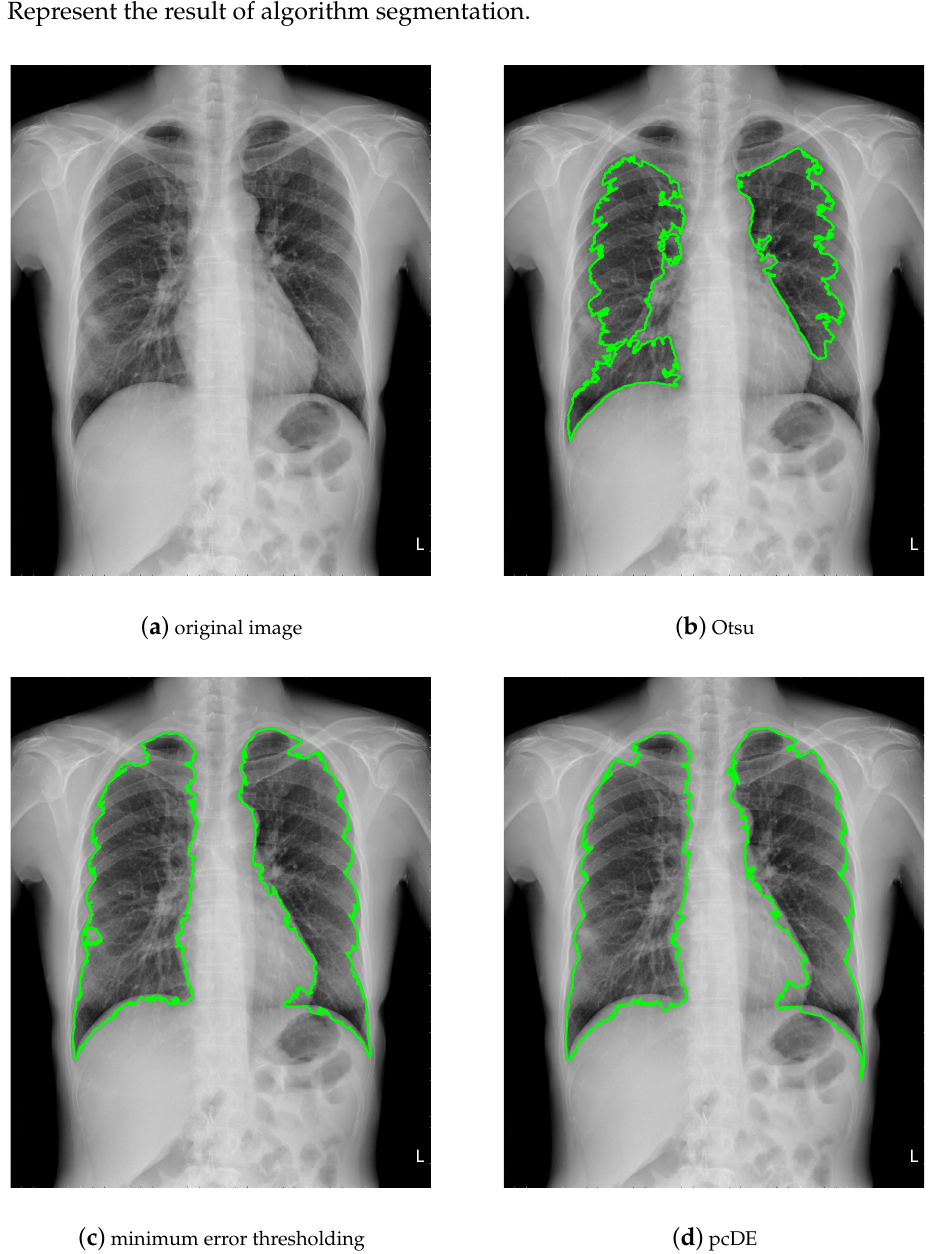
Figure 10. Contour marked